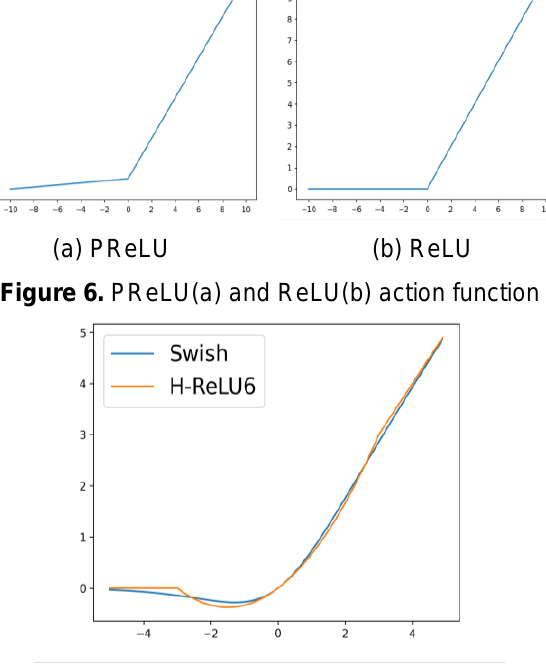
Figure 7. Swish and h-ReLU6 action function